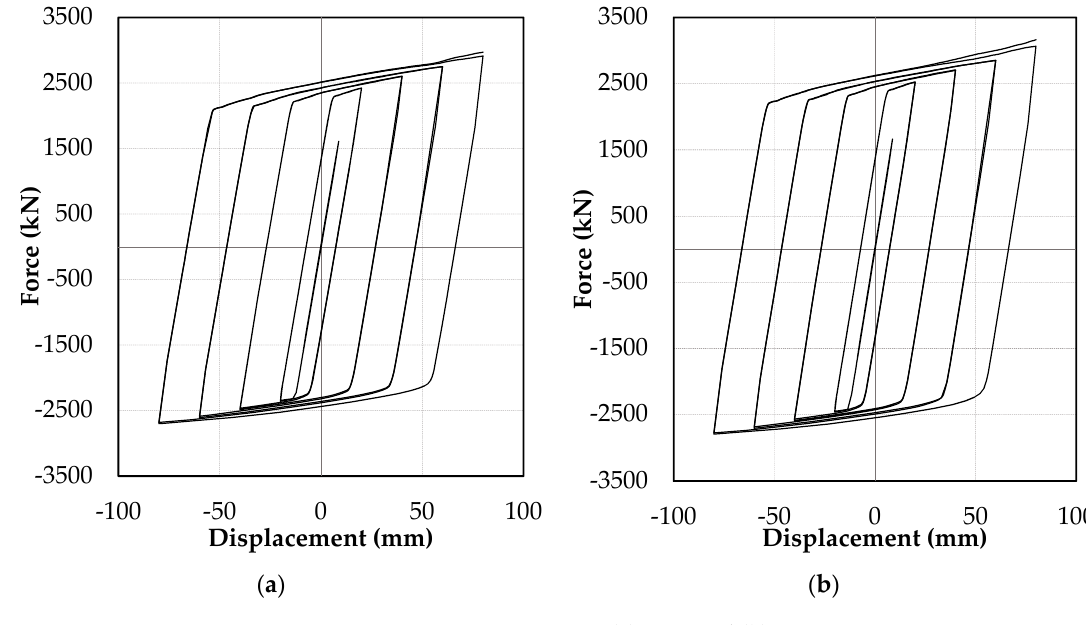
Figure 14. Hysteresis responses: ( a ) TF17 and ( b ) TF18.